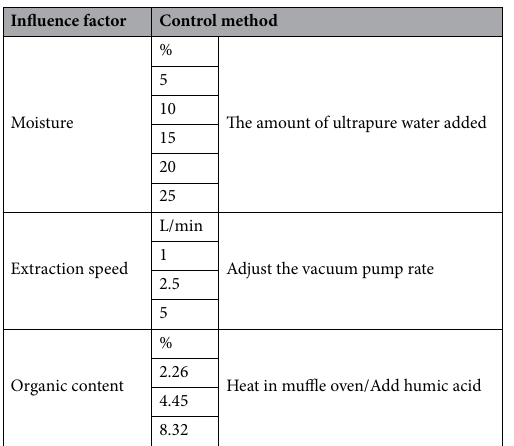
Table 3. Experimental design of the SVE and TOSVE